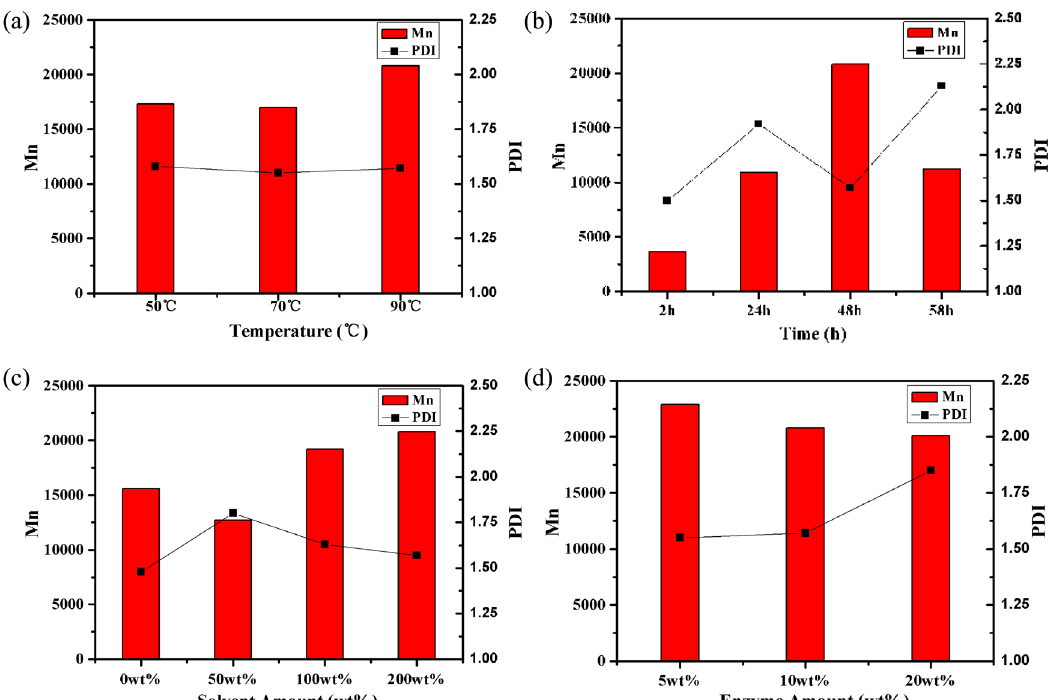
Figure 1: ( a ) Temperature e ff ects on the M n and PDI of PHK ( 48 h, 10 wt% CALB, 200 wt% diphenyl ether ) ; ( b ) reaction time e ff ects on the M ( 10 wt% CALB, 200 wt% diphenyl ether ) ; ( c ) solvent amount e ff ects on the M n and PDI of PHK and ( d ) enzyme amount e ff ects on the M n and PDI of PHK ( 90°C, 48 h, 200 wt% diphenyl ether ) .